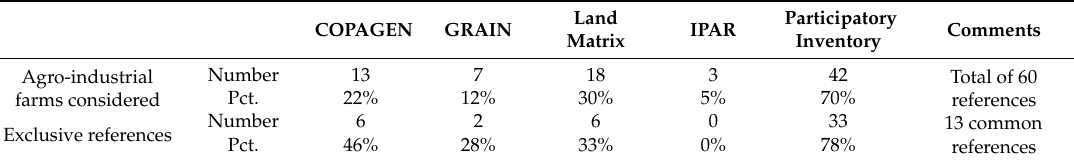
Table 1. Comparison of current and prior inventories compiled through different methodologies. COPAGEN